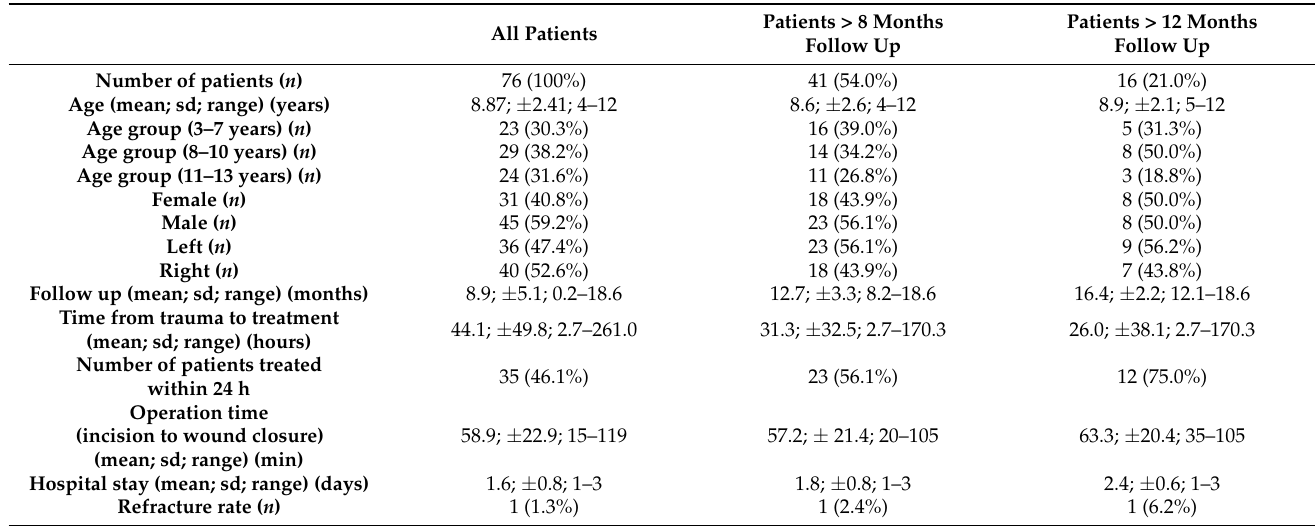
Table 4. Patients’ characteristics and preliminary results (pilot